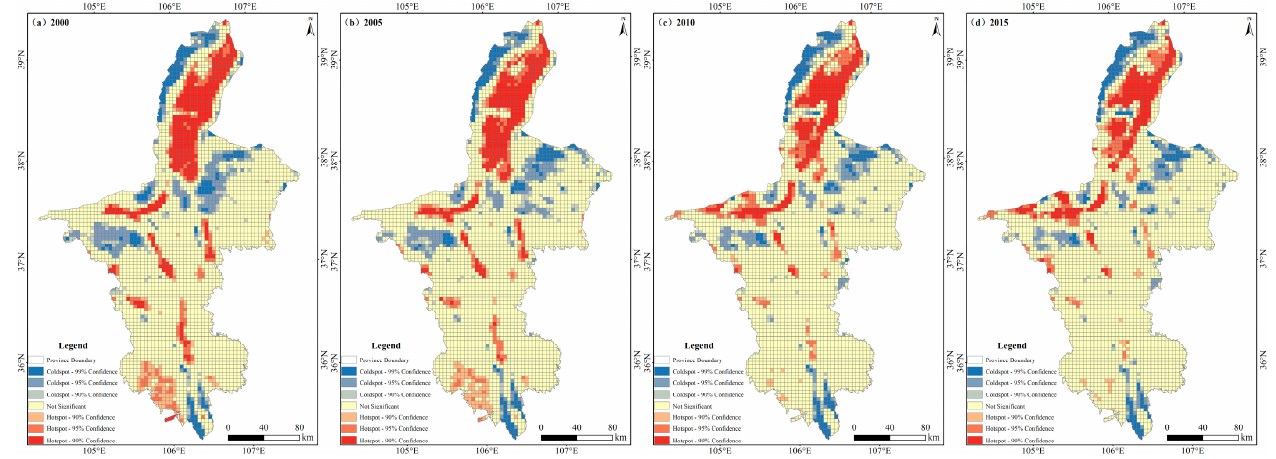
Figure 6. Hotspot map of LERI in Ningxia from 2000 to